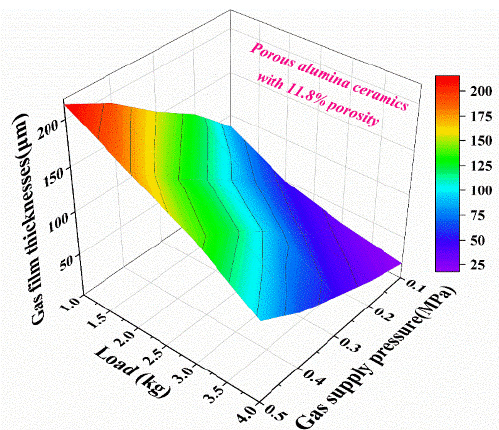
Figure 9. Gas film thicknesses at different gas supply pressure and load.